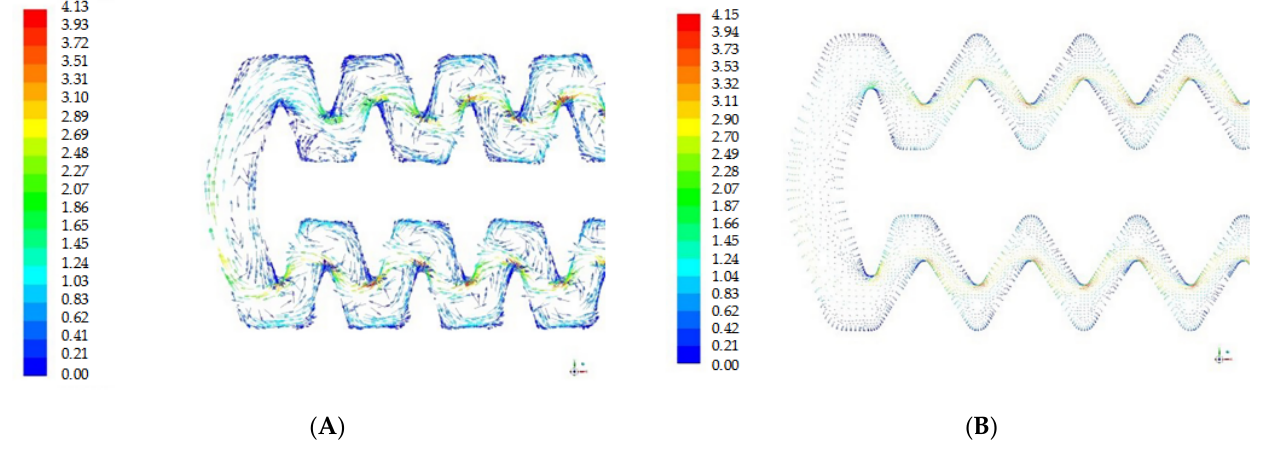
Figure 16. Velocity vector diagram of the flow channel for 0.1 MPa. ( A ) Control group (before optimization). ( B ) Plan 3 (after optimization).